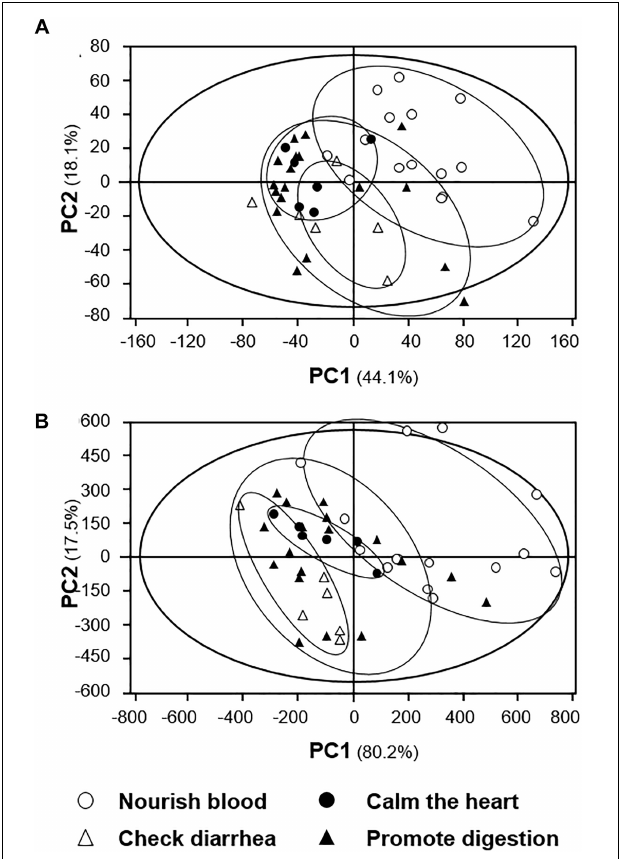
FIGURE 7 | PCA analyses of (A) TIC and (B) spectrum profiles of signals from the 15 spleen-meridian herbs. Similarly, the distribution of each herbal extract in score scatter plots was calculated according to its correlation with the major components. The classification of the herbal extracts was according to the proposed pharmacological activity, as described in TCM practice. The results showed relatively higher discrimination between different types of